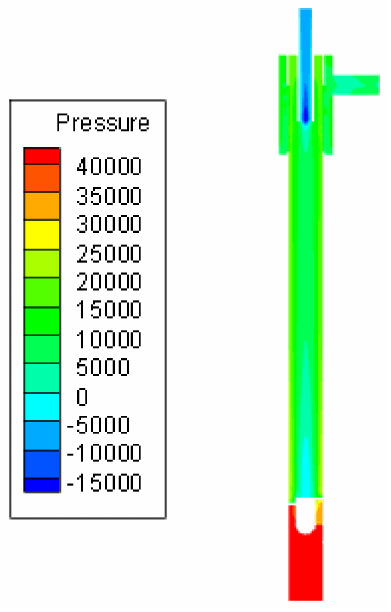
Figure 12. Distribution cloud of pressure inside the